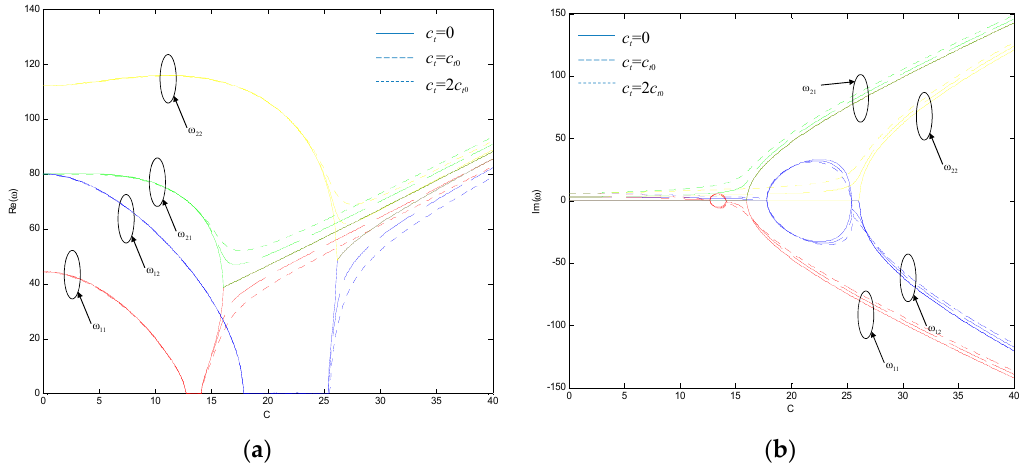
Figure 9. Effect of the Pasternak’s modulus k G on dimensionless complex frequencies of the axially-moving nanoplate.